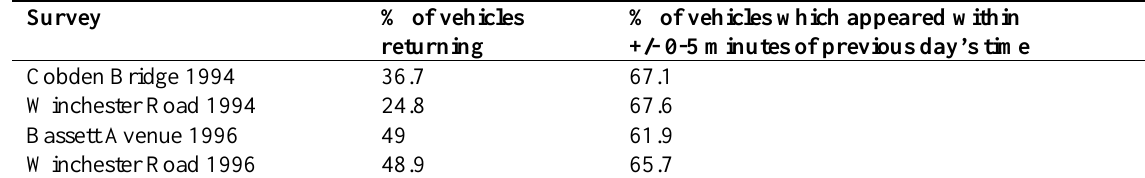
Table 3. Daily re-appearance rate and timings of vehicles in the 1994 and 1996 surveys. Survey % of